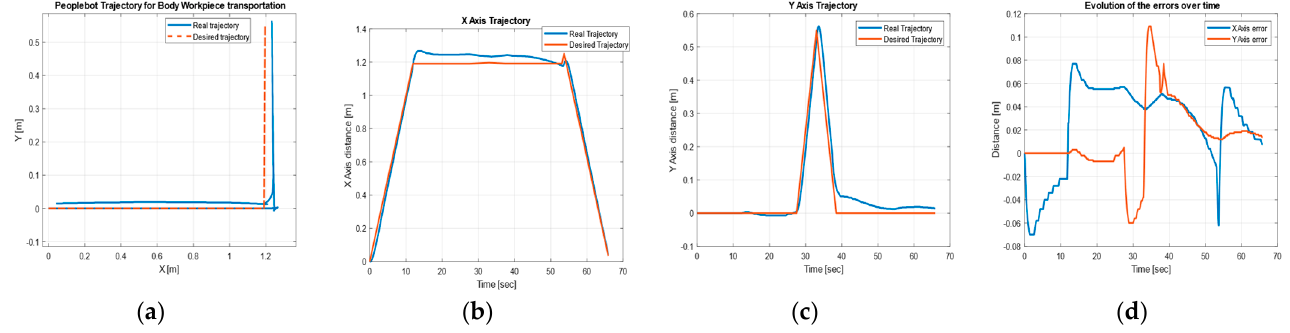
Figure 25. CAS’s DT-TTSMC for top recovery: ( a ) desired and real trajectory; ( b ) along the X axis; ( c ) along Y axis; ( d ) errors.